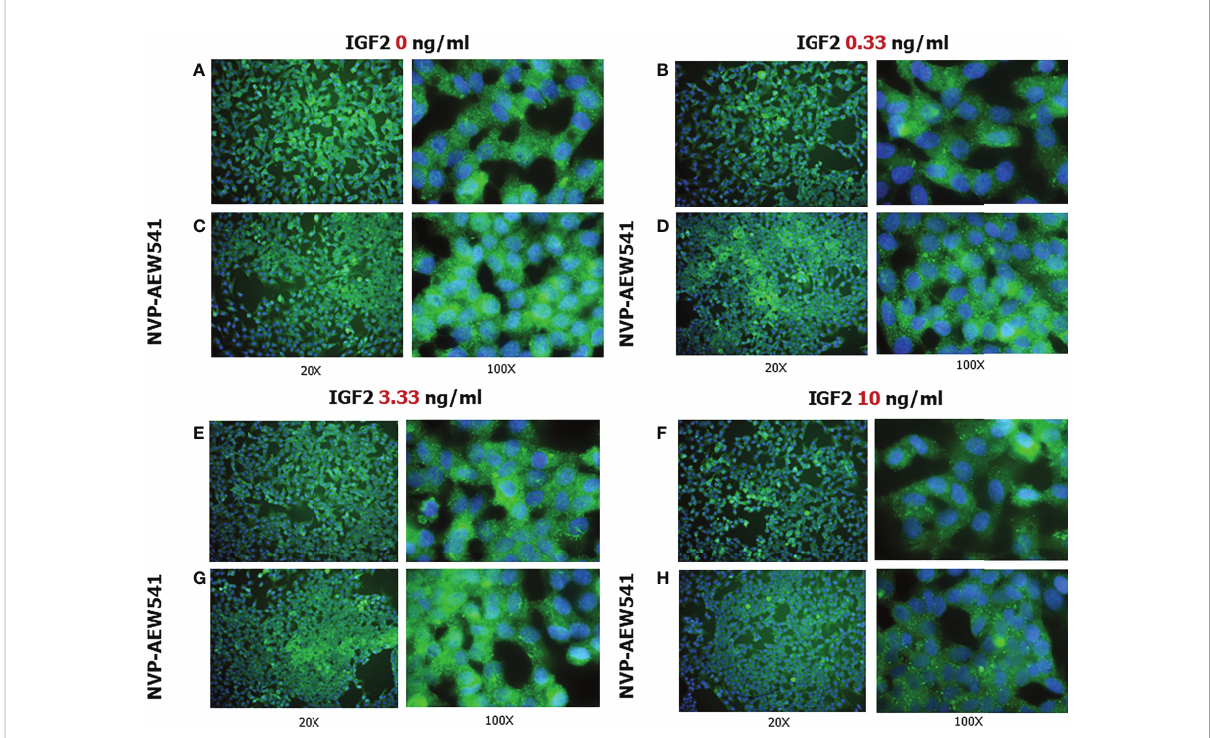
FIGURE 6 FSHR protein expression in Sertoli cells (SCs). Immuno fl uorescence analysis of the FSHR protein expression without treatment (A) or after incubation with NVP-AEW541 (B) , IGF2 0.33 ng/ml (C) , NVP-AEW541 + IGF2 0.33 ng/ml (D) , IGF2 3.33 ng/ml (E) , NVP-AEW541 + IGF2 3.33 ng/ ml (F) , IGF2 10 ng/ml (G) , and NVP-AEW541 + IGF2 10 ng/ml (H) . Blu: DAPI (nuclei), Green: dy-light 488. Magni fi cation 20x (left column) and 100x (right column) for each panel. The positive control is shown in Panel (A) , upper right and left. The negative control is shown in Supplementary Figure 1.